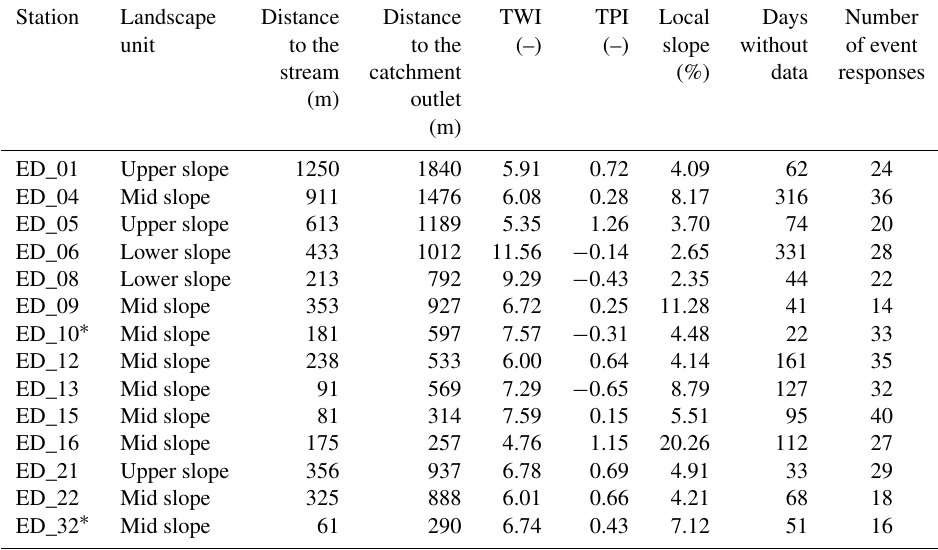
Table 2. Soil moisture (SM) measurement stations and their properties. ∗ denotes a temporary station. Distance to the stream and the catchment outlet are the distances along the surface flowpath from the SM station’s location to the nearest stream reach and catchment outlet, respectively. TWI and TPI are the topographic wetness and topographic position index, respectively. The last column shows the number of events when a response was